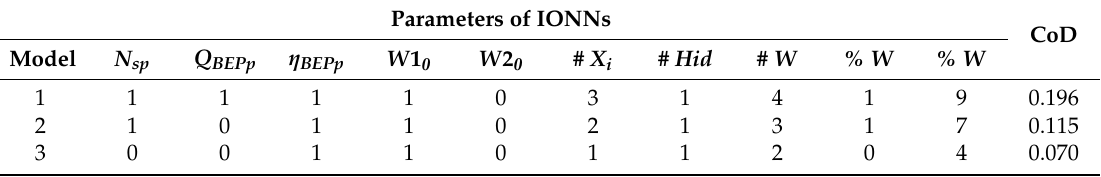
Table 9. Pareto front of IONNs for h for a linear transfer